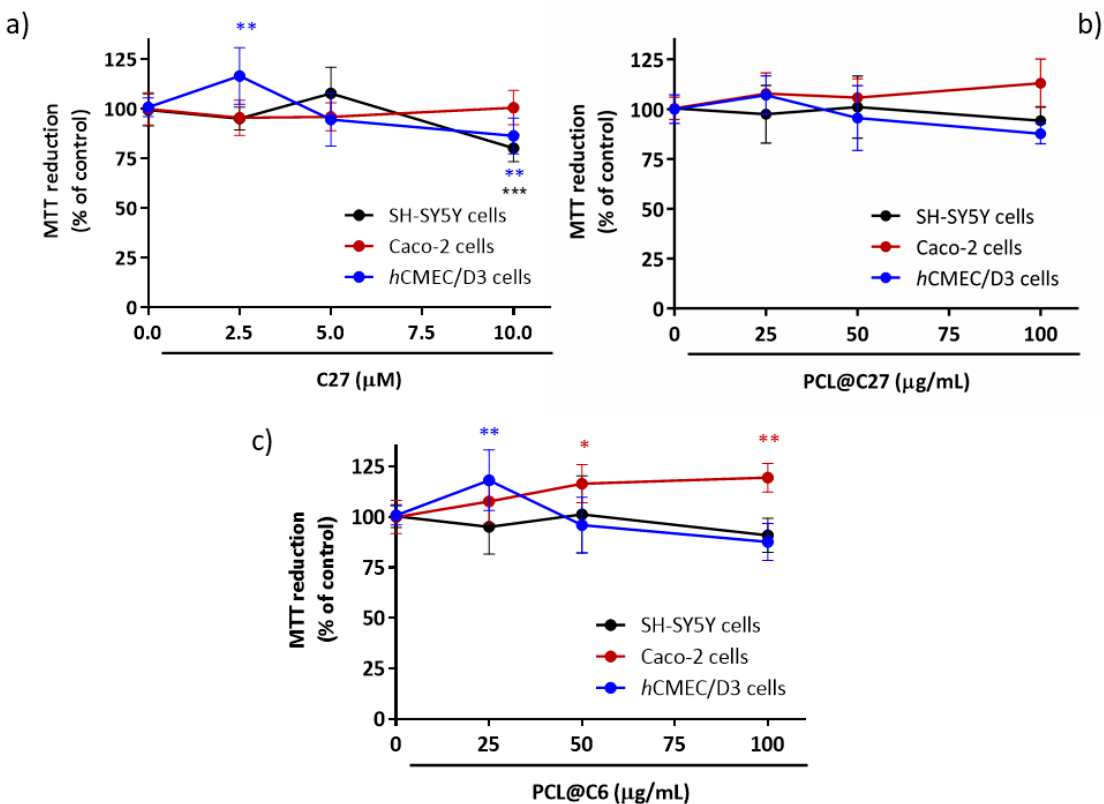
Figure 6. Cytotoxicity profile of C27 at 2.5, 5, and 10 µM ( a ) as well as nanoformulations of PCL@C27 ( b ) and PCL@C6 NPs ( c ) at 25, 50, and 100 µg/mL in different cells lines, evaluated by the MTT reduction assay 24 h after exposure. Results are expressed as mean percentage of MTT reduction ± SD